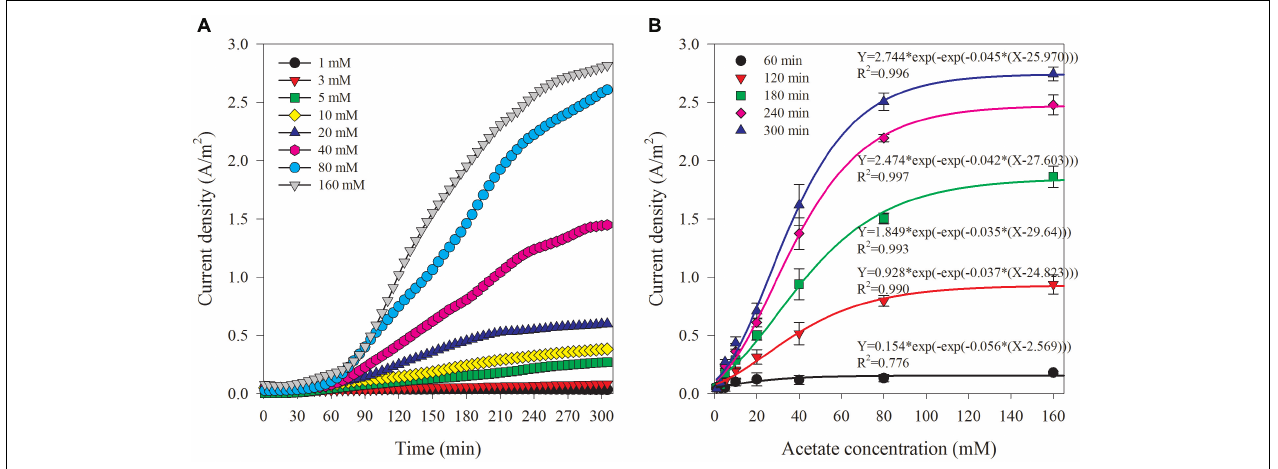
FIGURE 2 | Typical variation of current density corresponding to different acetate concentration in the artificial AD effluent (A) and the relationship between current density and acetate concentrations at varied reaction time (from 1 to 5 h) (B)